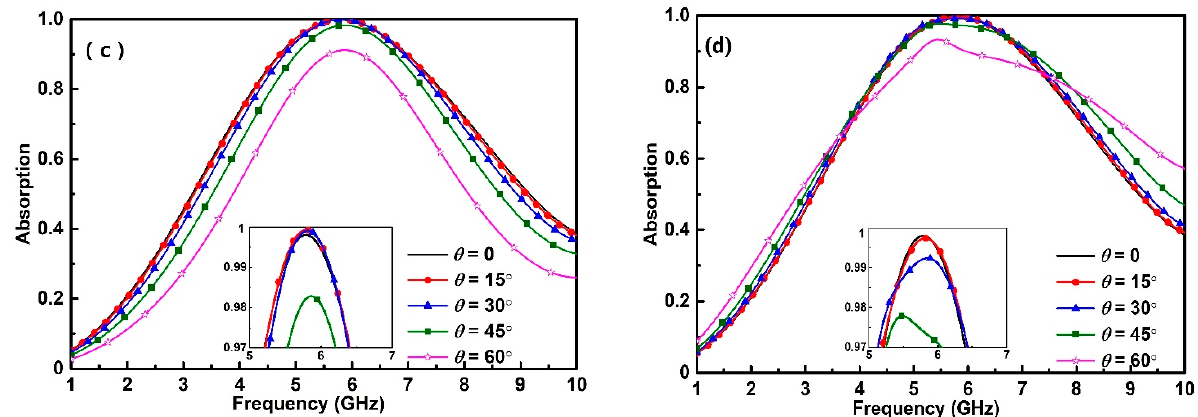
Figure 2. Absorption spectra of ( a ) the TE and TM polarization at the normal incidence, ( b ) at various polarization angles, and ( c ) at various incident angles of ( c ) the TE and ( d ) TM polarization.